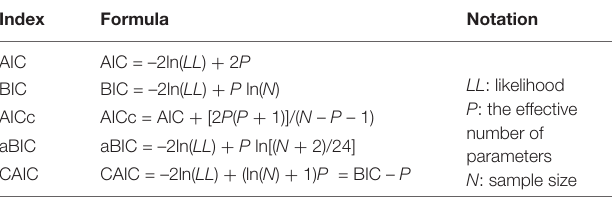
TABLE 2 | Formulas of different relative fit